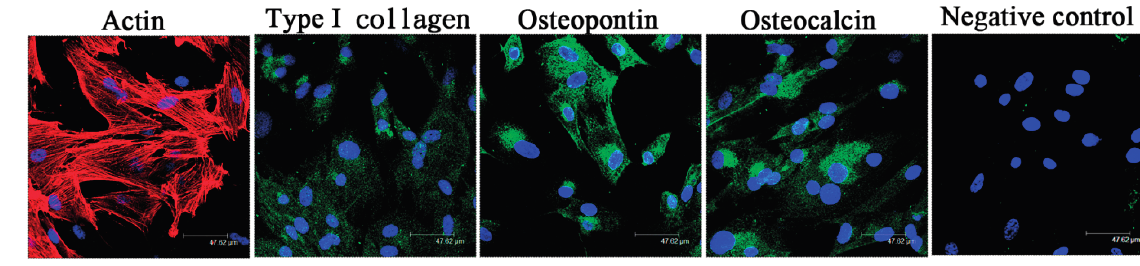
Figure 2. Immunofluorescence staining of Actin, type I collagen, osteopontin, osteocalcin, and negative control for LF cells cultivated on culture dish.